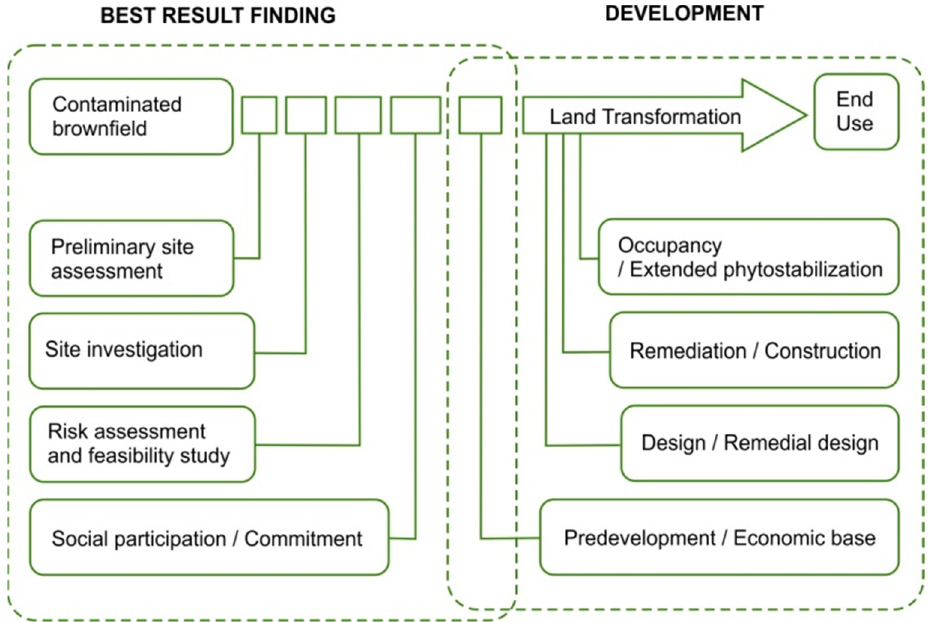
Figure 3. Stages of a contaminated spoil heap development. Adapted from [1] with the change regarding one-stage implementation.